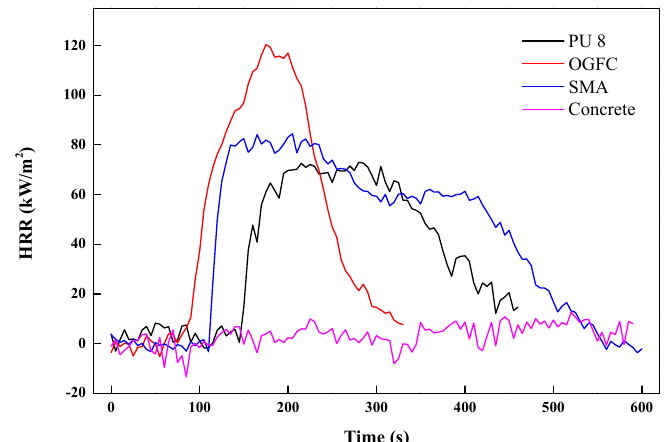
Figure 11. Comparison of heat release rate (HRR) among PU, OGFC and SMA.